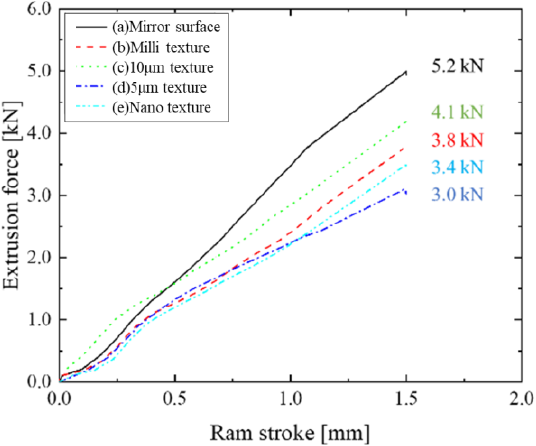
Figure 4. Extrusion force – ram stroke curve in each punch.